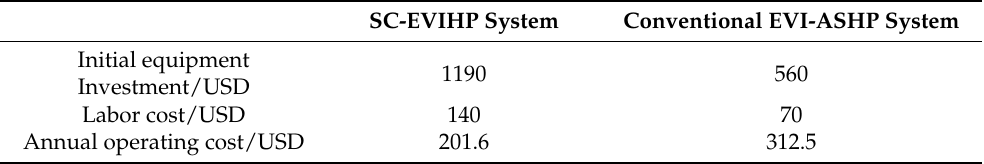
Table 4. Economic benefit